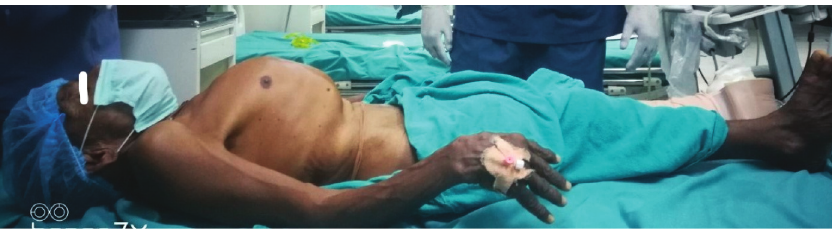
Figure 4: Obvious chest